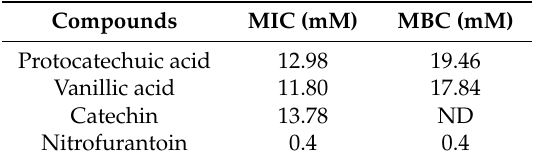
Table 1. Minimum inhibitory concentration (MIC) and minimum bactericidal concentration (MBC) of phenolic compounds against uropathogenic E. coli at the planktonic level. Compounds MIC (mM)